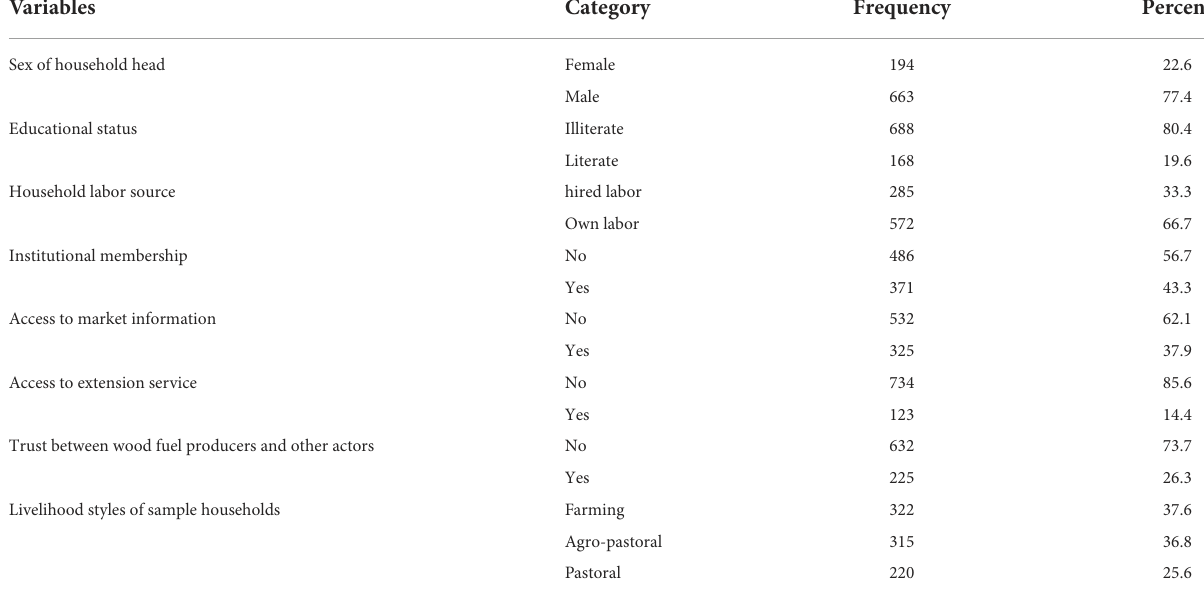
TABLE 2 Description of dummy socio-economic characteristics of